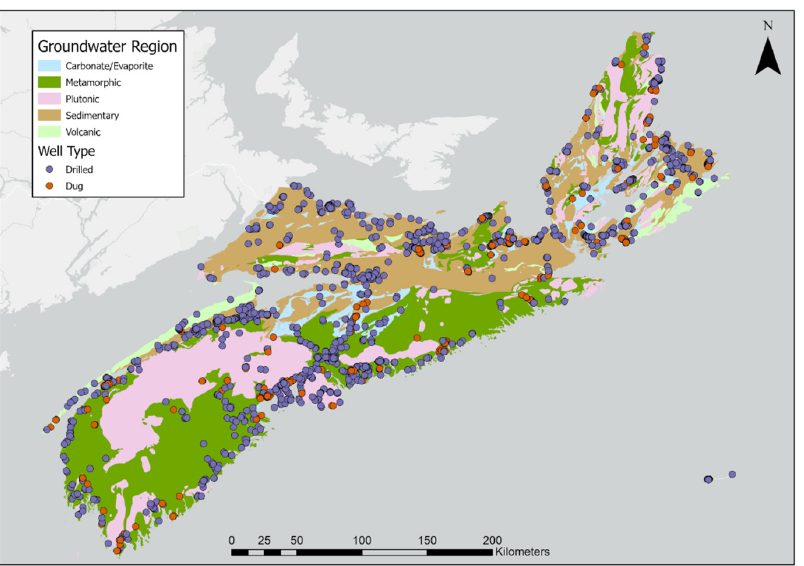
Figure 2. Distribution of aluminum in well water samples and well types compared to the bedrock groundwater regions of Nova Scotia.